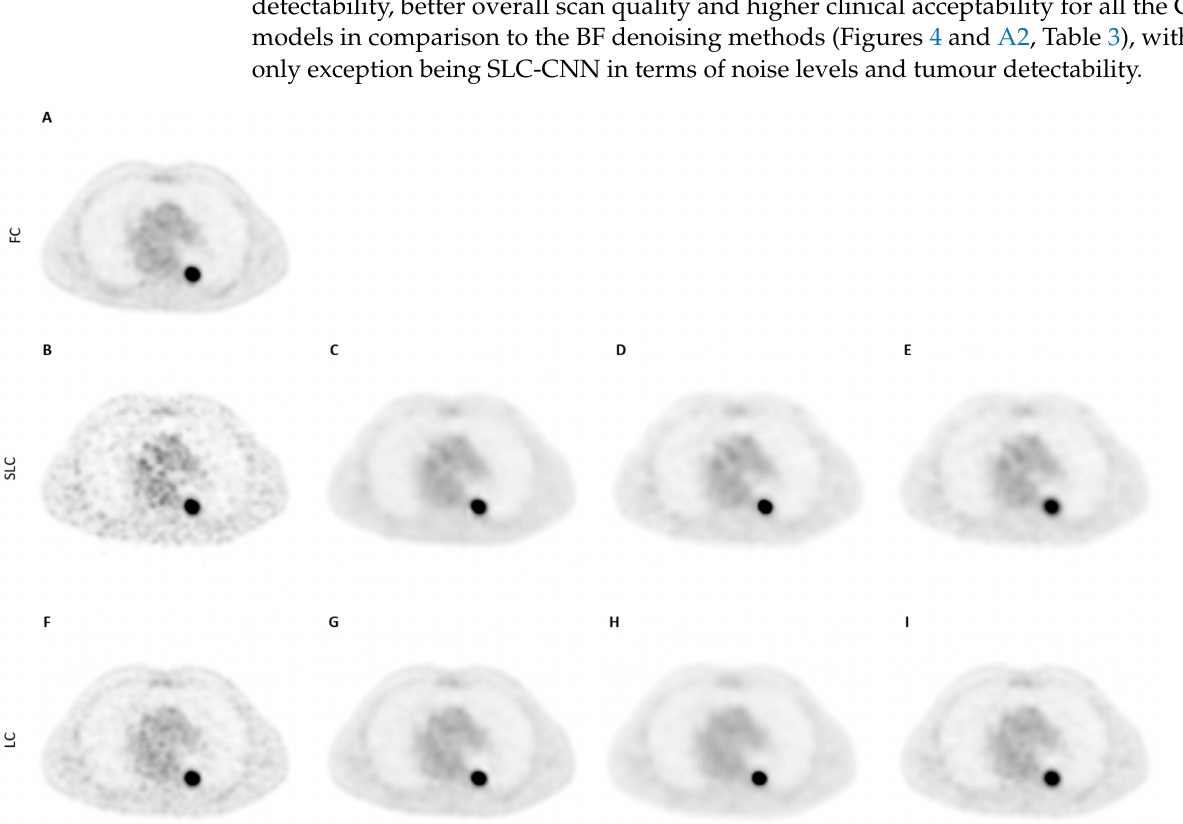
Figure 4. Illustration of a ( A ) FC, ( B ) SLC, (C) SLC-CNN, ( D ) BF 4 mm, ( E ) GS 10 mm denoised 18 F-FDG PET scan (axial orientation) from the Ingenuity TF PET/CT scanner. Illustration of a ( F ) LC, ( G ) LC-CNN, ( H ) BF 4 mm, ( I ) GS 6 mm denoised 18 F-FDG PET scan (axial orientation) from the Ingenuity TF PET/CT